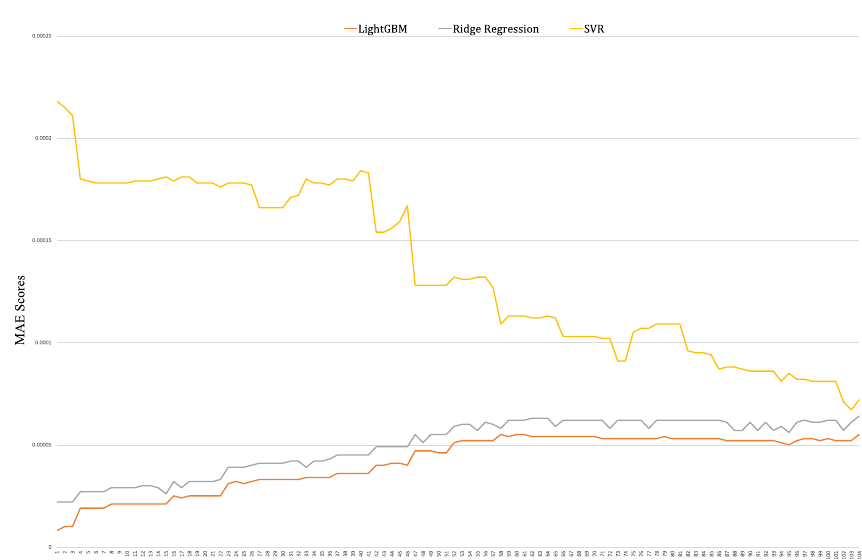
GF POS-based model with respect to MAE scores and feature + +